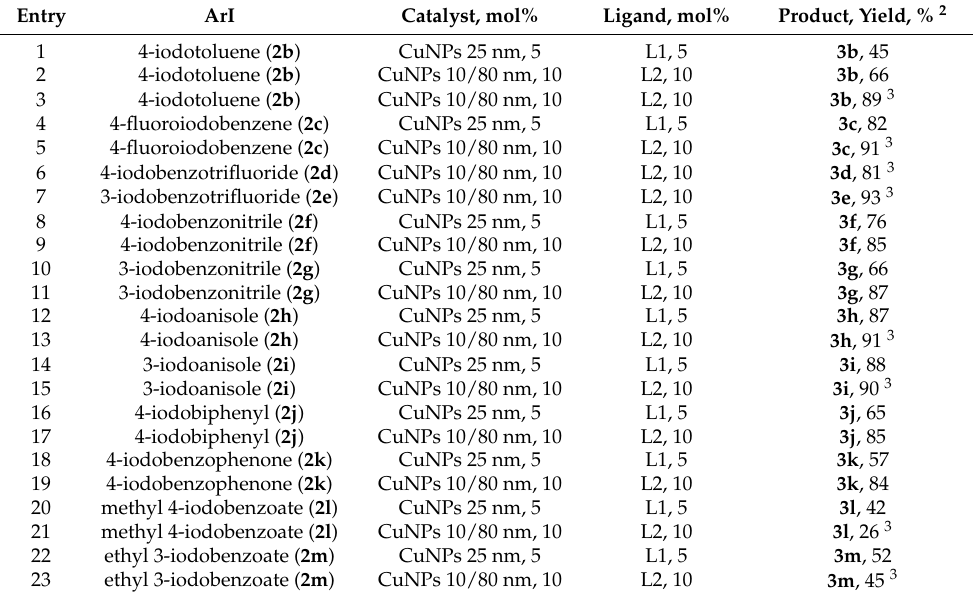
ethyl 3-iodobenzoate ( 2m ) CuNPs 10/80 nm,